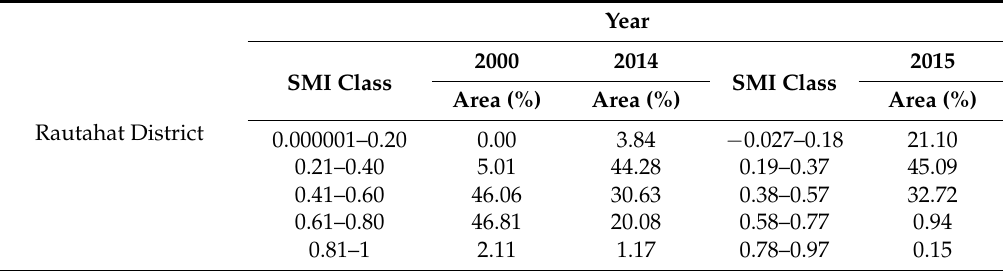
Table 5. Area (in %) covered by different SMI values in Rautahat